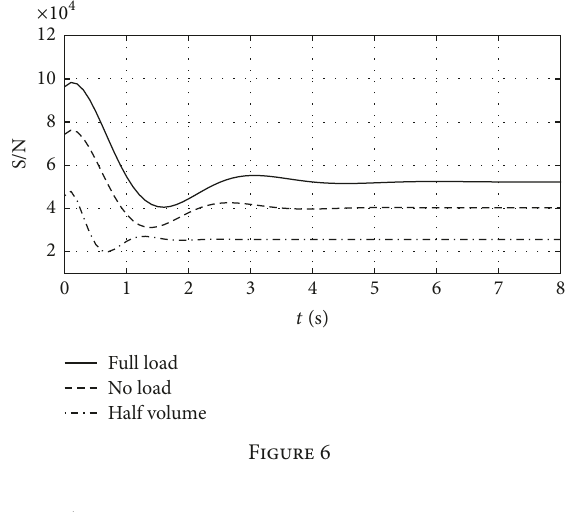
Table 2: Simulation parameters for the considered belt